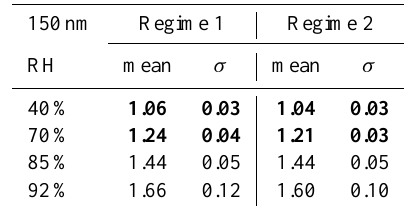
Table 2. Hygroscopic growth factors (150nm dry diameter) aver- aged over the two meteorological regimes. For the bold values, the difference of the means between Regime 1 and Regime 2 is sta- tistically significant (95% confidence level). “ σ ” denotes standard